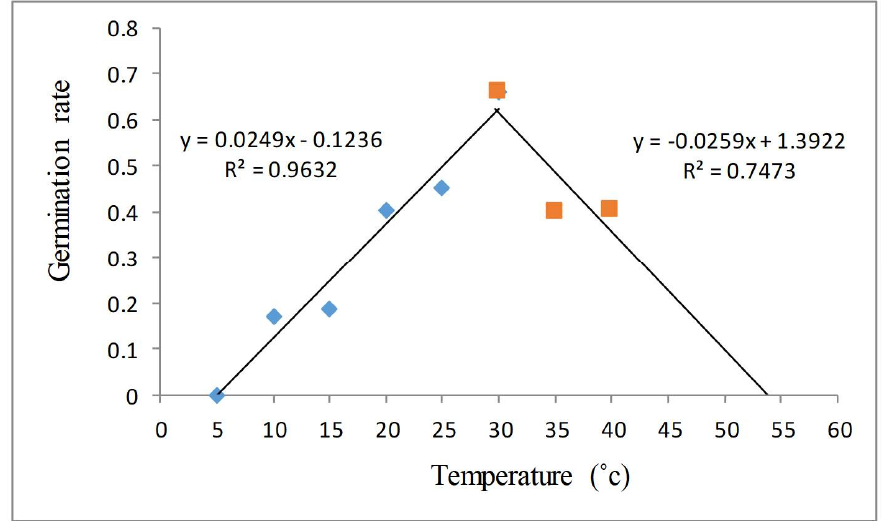
Figure 2. Germination rate response of Hibiscus sabdariffa seeds to temperature. By increasing temperatures, the GRs reached 0.51 and 0.66 seeds per day at 30 °C in light and dark conditions, respectively. Temperatures above 30 °C reduced GR and thus, by increasing temperature from 30 to 40 °C, the GRs were decreased to 0.35 and 0.40 seeds